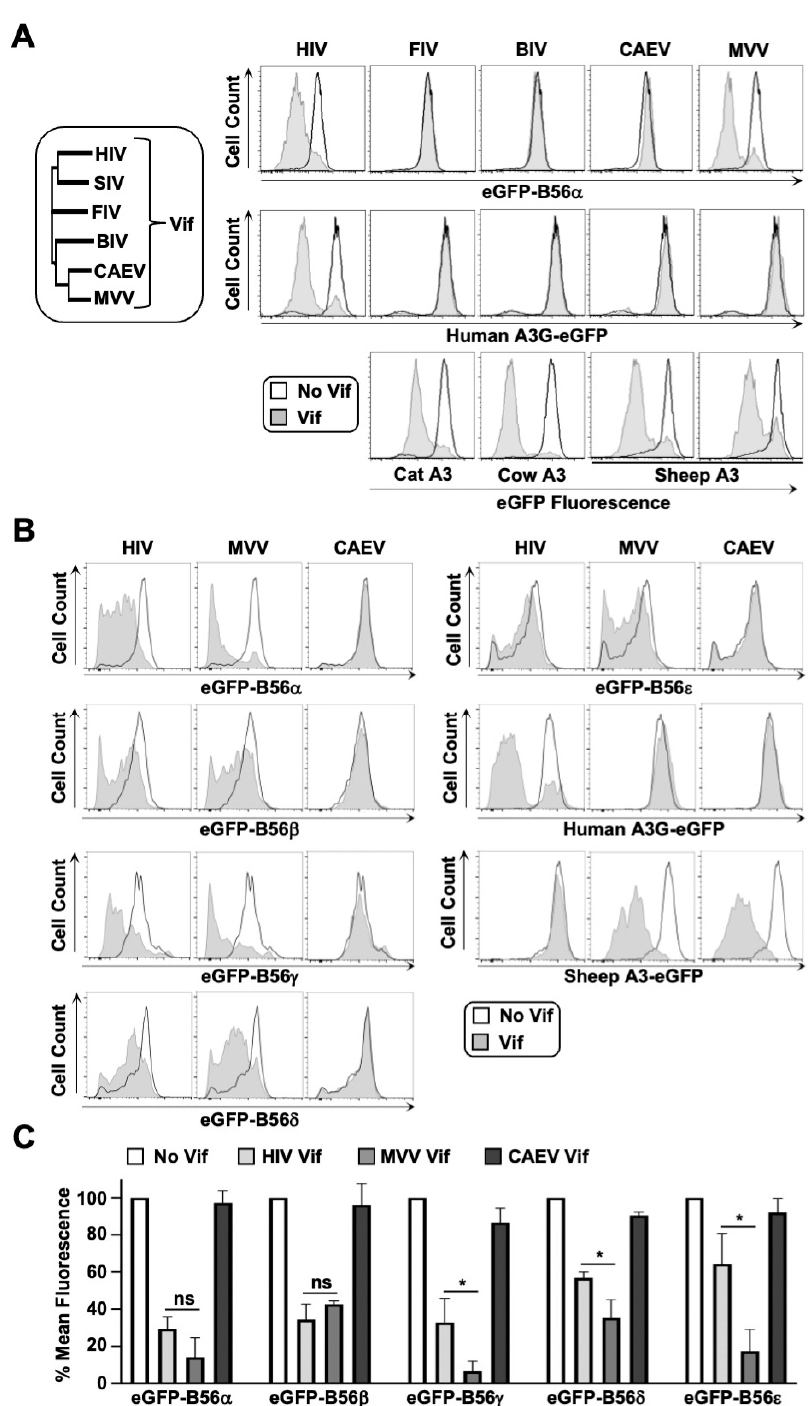
Figure 1. MVV Vif efficiently targets the family of B56 α - ε proteins for degradation. ( A , B ) low cytometry histograms of A3-eGFP or eGFP-B56 α degradation in the presence of the indicated Vif protein. The open histogram (black) represents the eGFP profile of cells expressing mTagBFP2 alone, whereas the filled histogram (grey) represents the profile of cells expressing the indicated Vif construct. The data shown are from one of three independent experiments. ( C ) Quantification of eGFP mean fluorescence intensity from cells expressing the indicated Vif proteins. ns, indicates no significance; * is p < 0.05 by unpaired student’s t -test. All experiments were repeated at least three independent